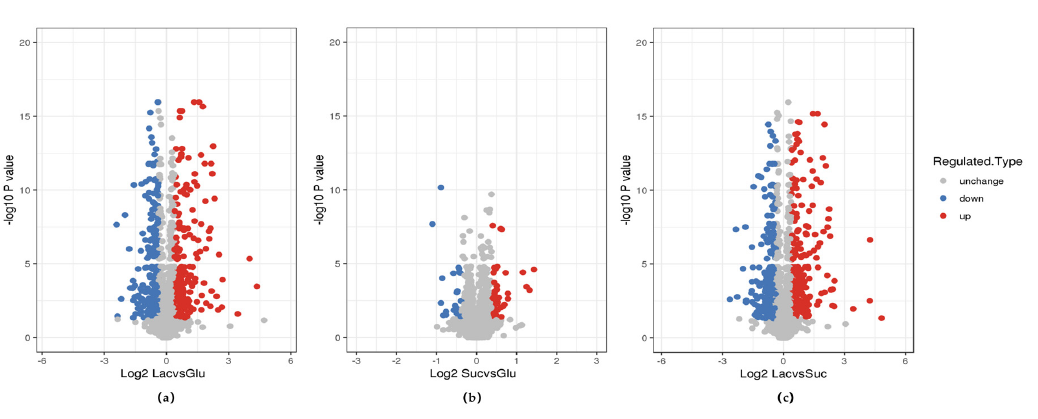
Figure 6. Quantitative volcanic map of differentially expressed proteins ( a ) group I, LEPS versus GEPS; ( b ) group II, SEPS versus GEPS; ( c ) group III, LEPS versus SEPS.